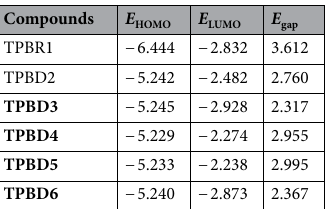
Table 1. HOMO/LUMO energies and band gaps of entitled compounds. Units in eV; E gap = E LUMO − E HOMO .